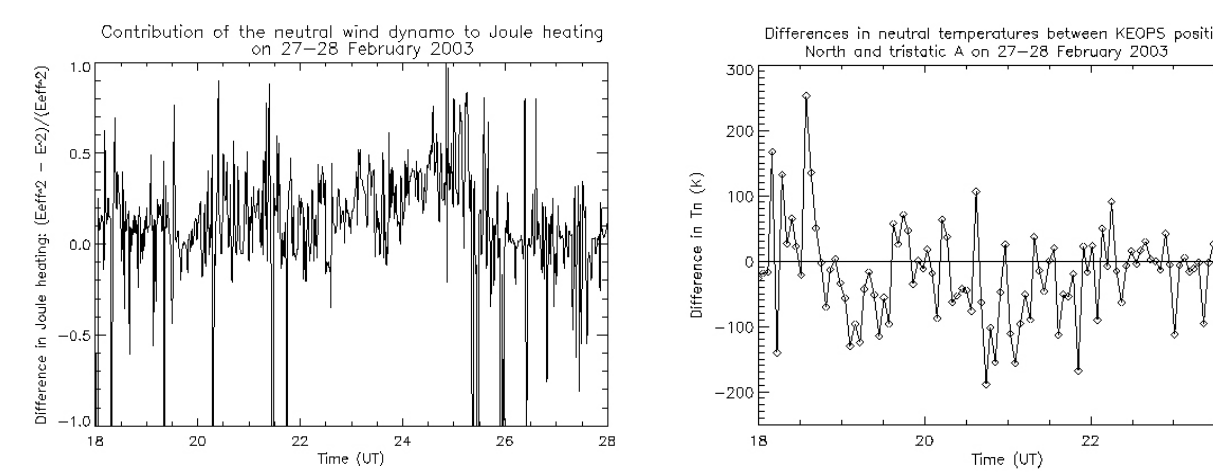
value of 1230 K around 20:30 UT. The neutral